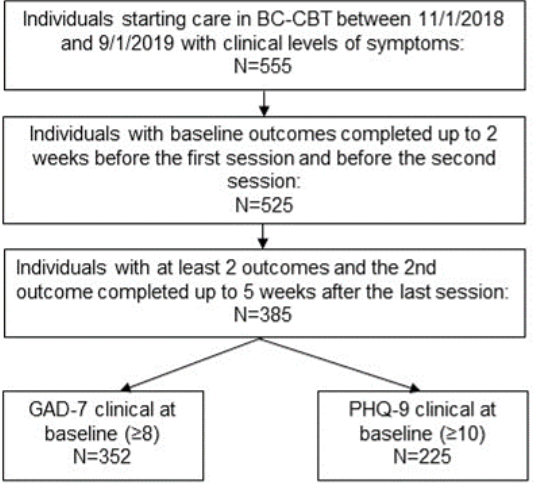
Figure 1. Participant